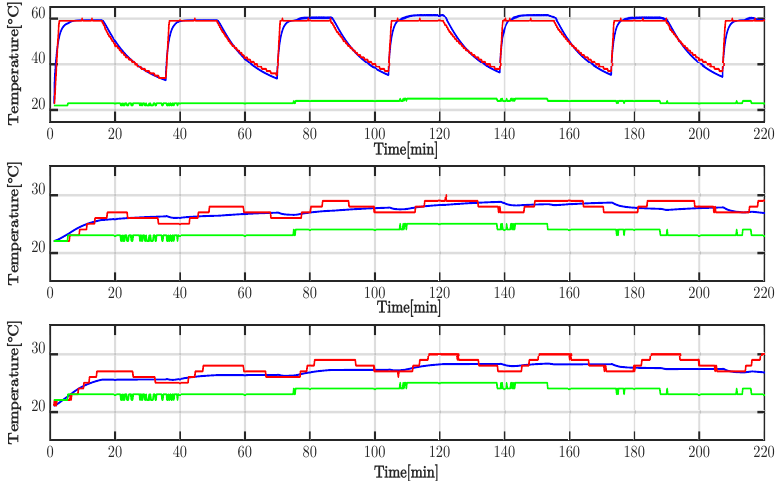
Figure 14. Experimental and simulated results for three thermal zones.